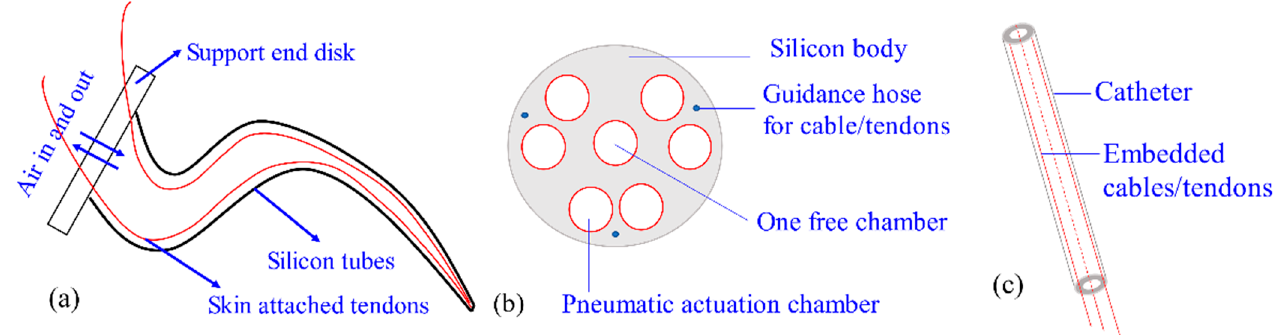
Figure 5. Soft-tube CCRs: ( a ) A silicone-tube CCR [4,54], ( b ) the cross section of another silicone-backbone CCR [55] and ( c ) a catheter CCR [56,57,62–65].